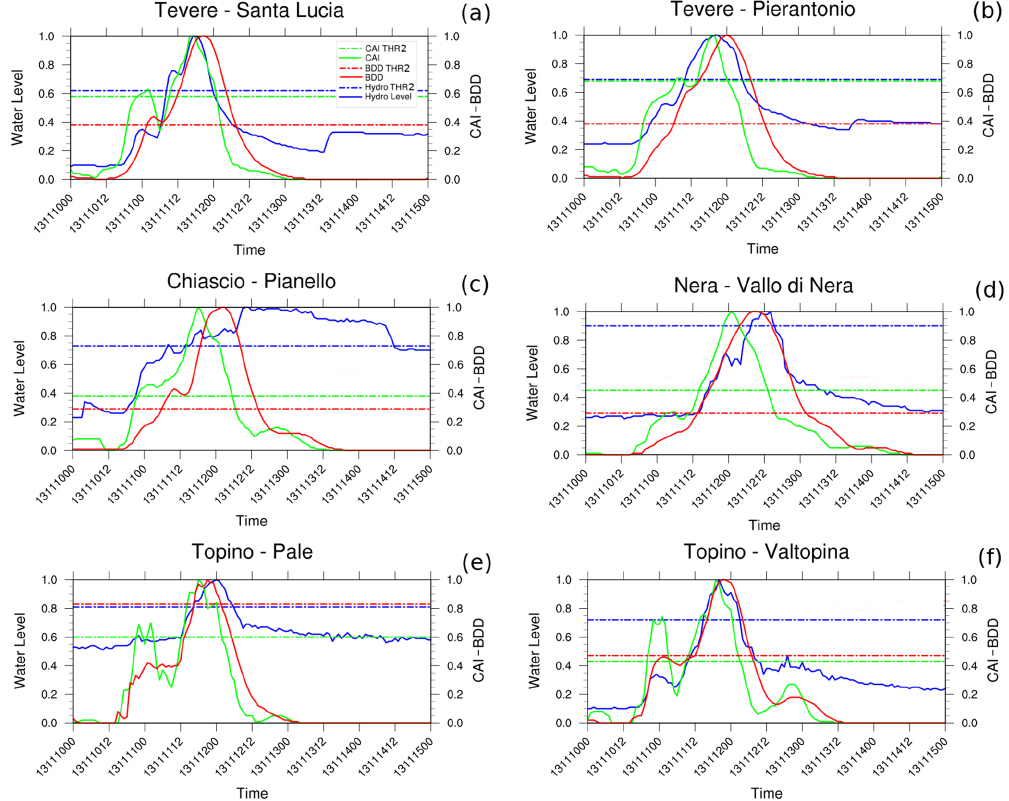
Figure 9. Time series comparison for six hydrometric stations: BDD hourly profile (red line), BDD moderate threshold (flat red line), CAI hourly profile (green line), CAI moderate threshold (flat green line), hydrometric-level hourly profile (blue line) and hydrometric-level moderate threshold (flat blue line). Quantity profiles and related thresholds are